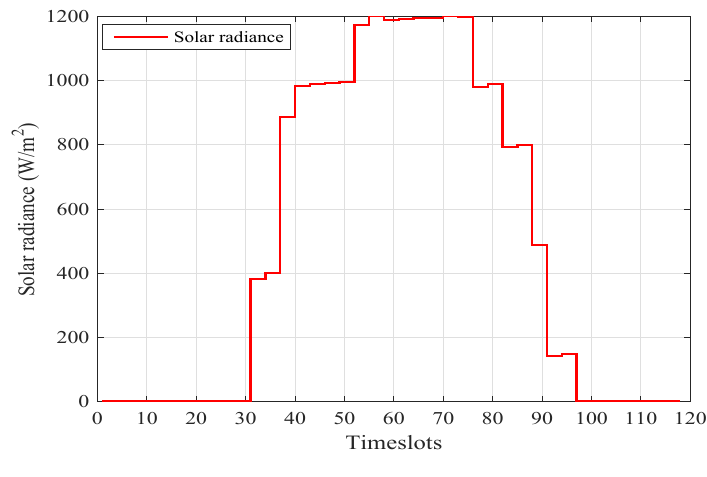
Figure 11. Solar irradiance